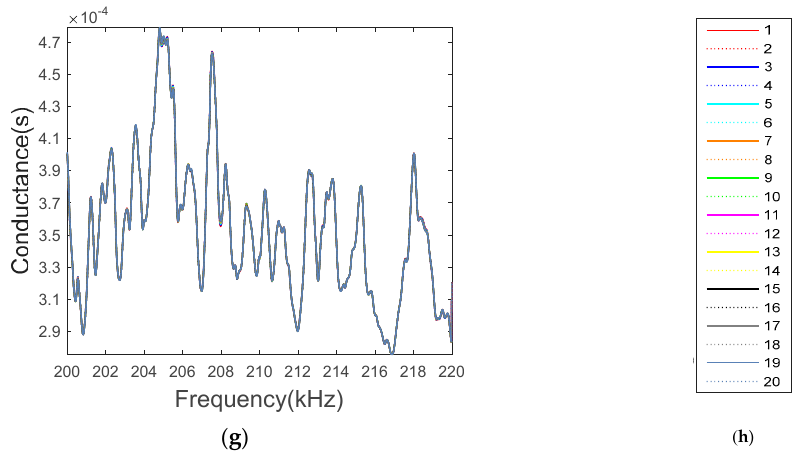
Figure 11. The conductance signatures for twenty repeated experiments at different torque levels. ( a ) 2.5 lb · ft, ( b ) 5.0 lb · ft, ( c ) 7.5 lb · ft, ( d ) 10.0 lb · ft, ( e ) 12.5 lb · ft, ( f ) 15.0 lb · ft, ( g ) 17.5 lb · ft, ( h ) Repetitions (in No.).